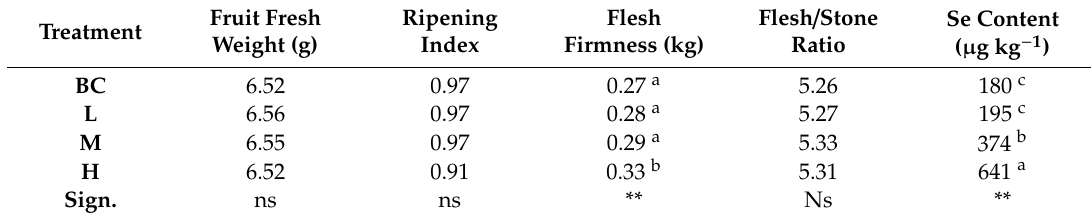
Table 3. Physical characteristics of olive fruits cv. “Gordal” at harvest after plant selenate spraying (0, 25, 50 and 75 mg L − 1 respectively for C, L, M, H). Fruit Fresh Ripening Flesh Treatment Weight (g) Index Firmness